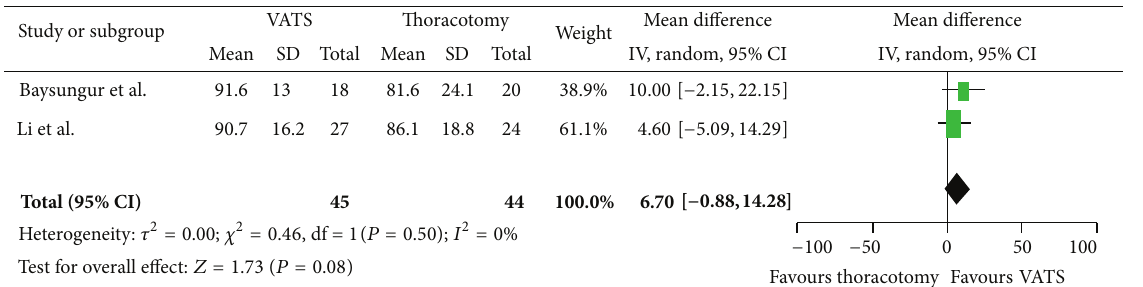
Figure 4: Forest plot for role limitation comparing VATS to